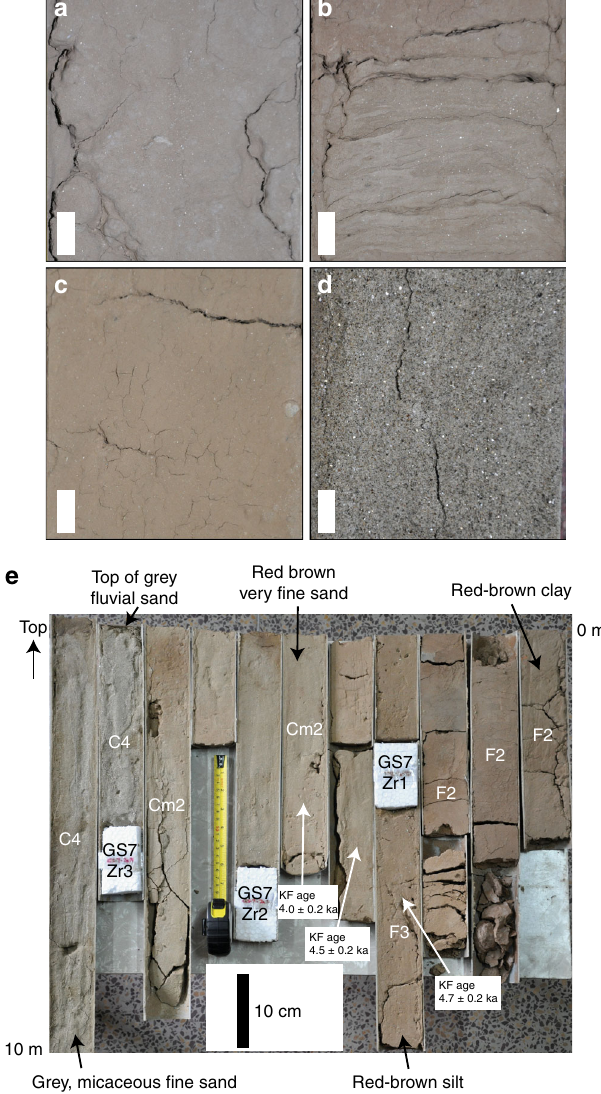
Fig. 6 Characteristics of sediments in cores. a – d Detailed sedimentary features of core recovered from GS10 at Kalibangan. Scale bar is 1 cm in all images. a Silty clay at 2 m depth, b interlaminated silt and very fi ne sand at 4 m depth, c red-brown clayey silt at 6.5 m depth, d grey micaceous fi ne sand at 17 m depth. e Core recovered from GS7 at Kalibangan at a depth of 10 to 0 m, from the centre of incised valley. Facies abbreviations: F2, red- brown silty clay. F3, red-brown very fi ne sand. Cm2, yellow-brown very fi ne sand. C4, grey fi ne, micaceous sand. Details of facies are summarised in Supplementary Table 2. The base of the section comprises unconsolidated grey micaceous fl uvial sands. Above these there is an abrupt transition into brown very fi ne sands and silts, and toward the top red-brown silty clays indicative of very low-energy depositional environments are present. Sampling points of detrital zircon samples GS7 Zr1-3 are indicated,